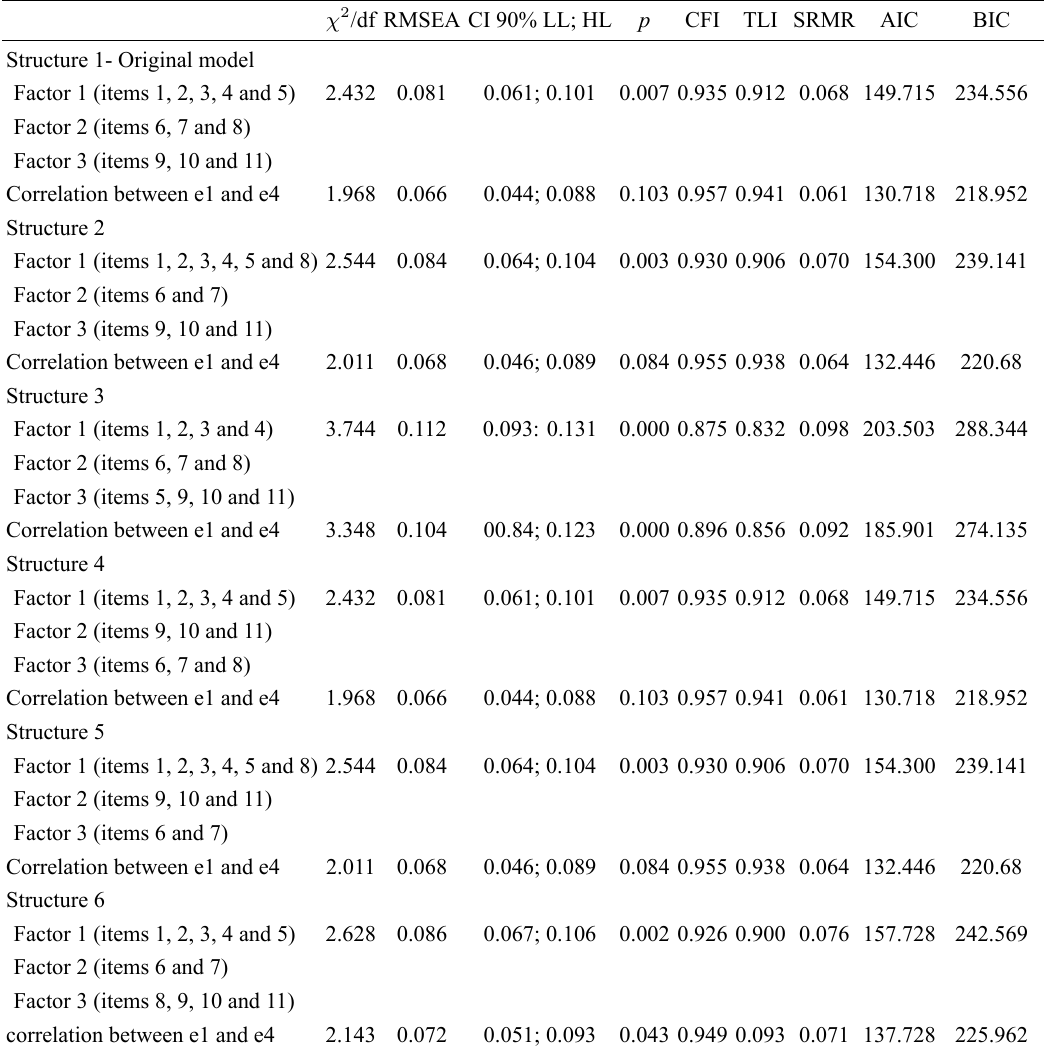
Table 3. Factorial structure of each EFA model and fit indices from CFA in the Portuguese Version of C19TSS (N =